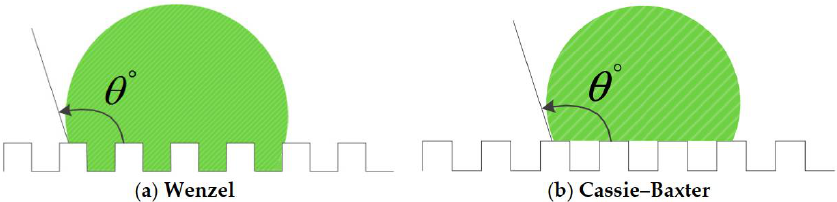
Figure 4. The states of droplets on roughness surface. ( a ) The Wenzel model. ( b ) The Cassie–Baxter model. Reprinted from Ref [45].